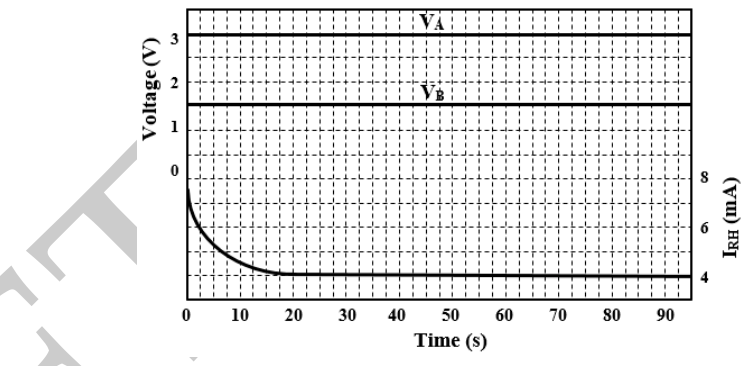
Figure 8. Transient response of the CTA circuit with V TR = 1.5 V.